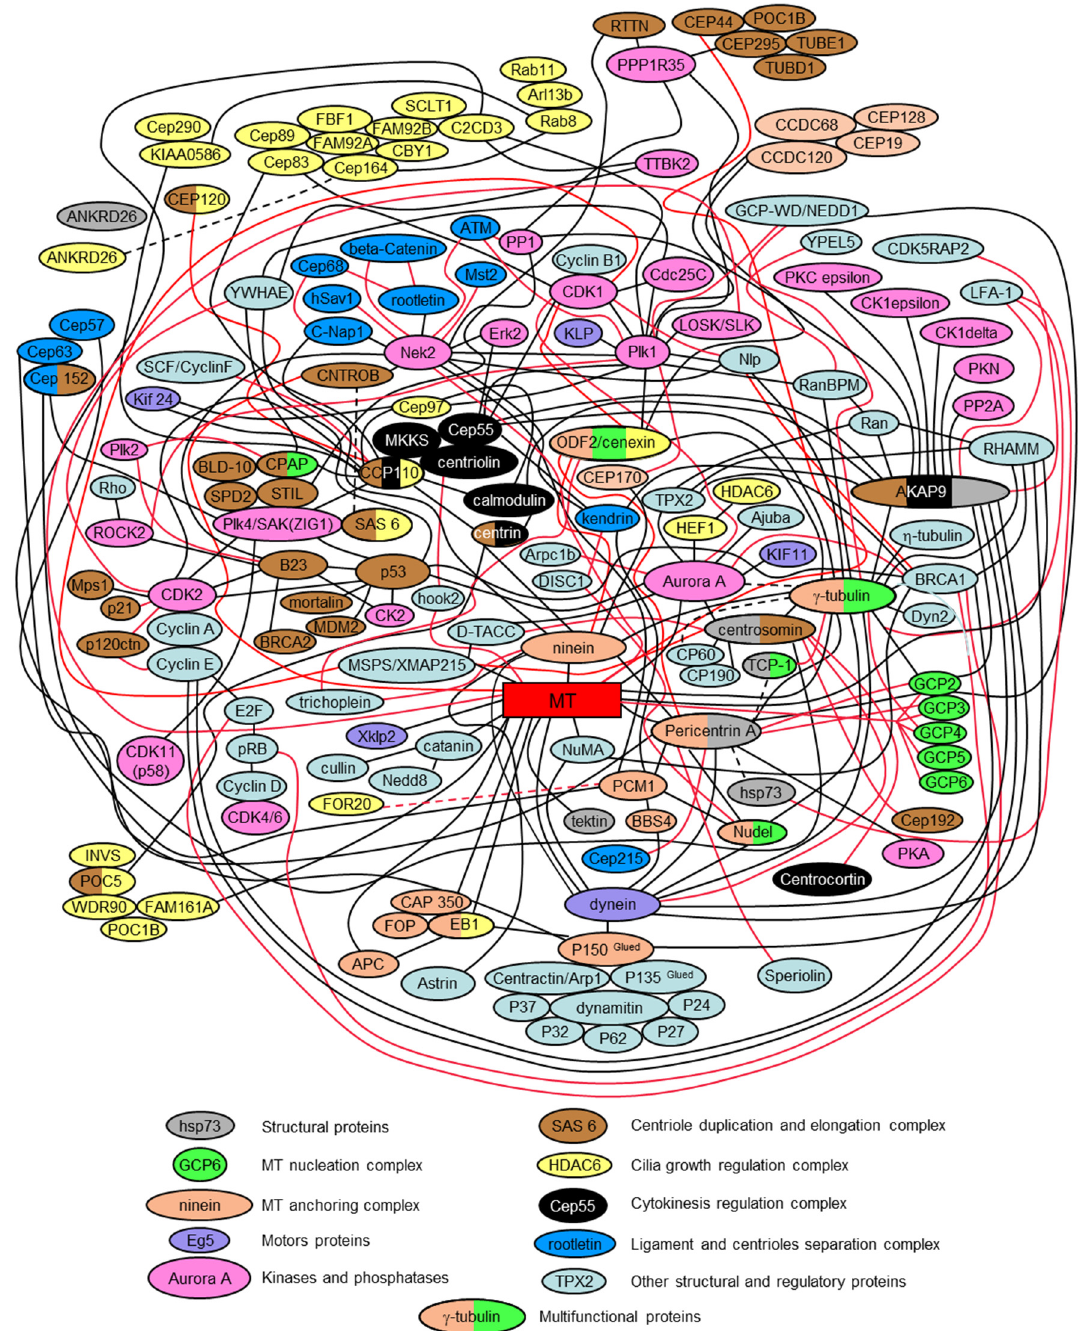
Figure 6. Scheme of protein interactions and functional protein complexes in centrosome (interactome) ([13] with modifications). Red and black lines mark centrosomal protein interactions.